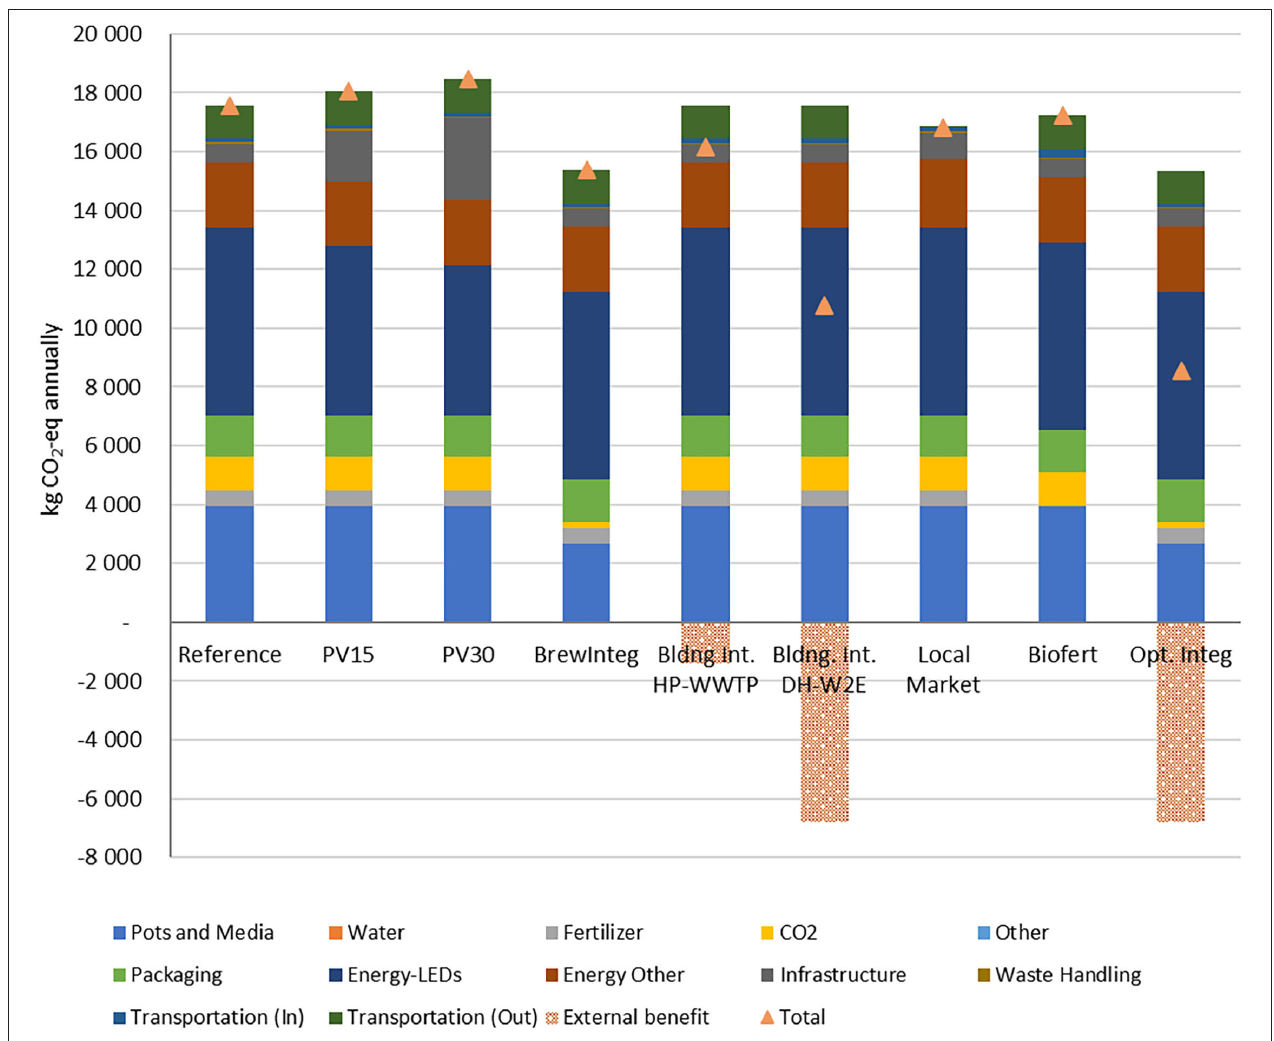
FIGURE 4 | Annual GHG emissions for different scenarios illustrating the contribution of different processes and the overall impacts (shown in kg CO 2 -eq